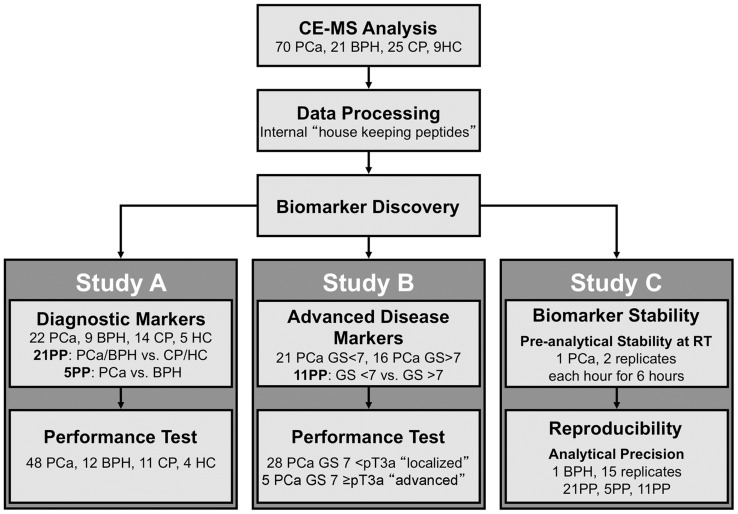
Flow chart of study design.For biomarker discovery in total 125 seminal plasma samples were used from 70 patients with PCa, 21 patients with benign prostate hyperplasia (BPH), 25 patients with chronic prostatitis (CP) and 9 healthy control (HC). This pool of available samples was used in varying composition in three study arms. In study A “Diagnostic Markers” 50/125 patients with and without prostate cancer (22 PCa, 14 CP; 9 BPH and 5 HC) were used for biomarker discovery and the remaining 75/125 patients (48 PCa, 12 BPH, 11 CP, and 4HC) were used for diagnostic performance tests. In Study B “Advanced Disease Markers” available PCa samples (n = 70) were stratified according to Gleason score. For biomarker discovery patients with Gleason score <7 (n = 21) and Gleason score >7 (n = 16) were compared. The remaining 33/70 patients with Gleason score 7 (28 indolent disease <pT3a and 5 ≥pT3a advanced disease according EUA guidelines) were used for testing clinical performance. Furthermore, in study C preliminary assessment of stability and precision of the approach was performed.